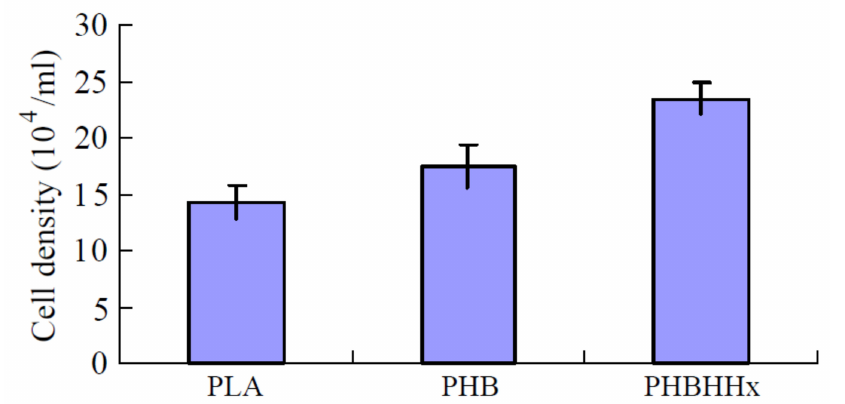
Figure 3. After 10 days of incubation, MTT assay for rabbit bone marrow cell proliferation on PLA, PHB, and PHBHHx